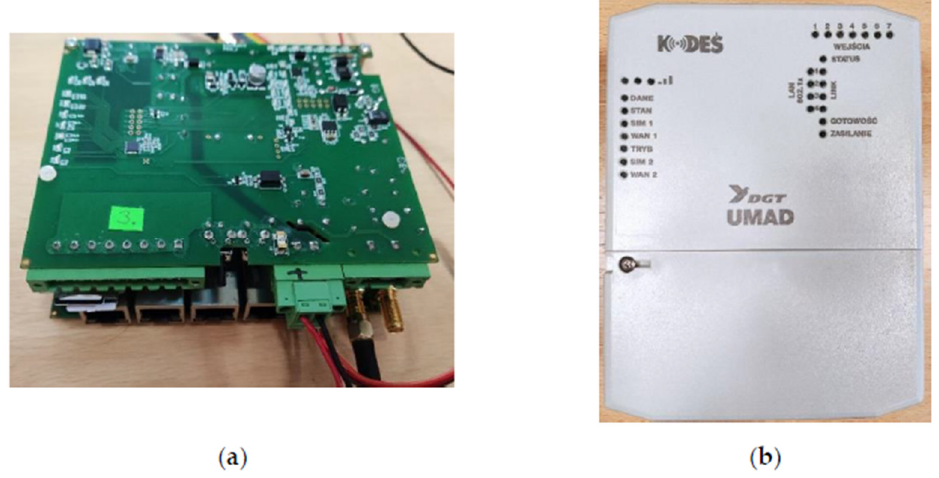
Figure 2. KODEŚ device: ( a ) without cover; ( b ) with cover. Figure 2. KODE ´ S device: ( a ) without cover; ( b ) with